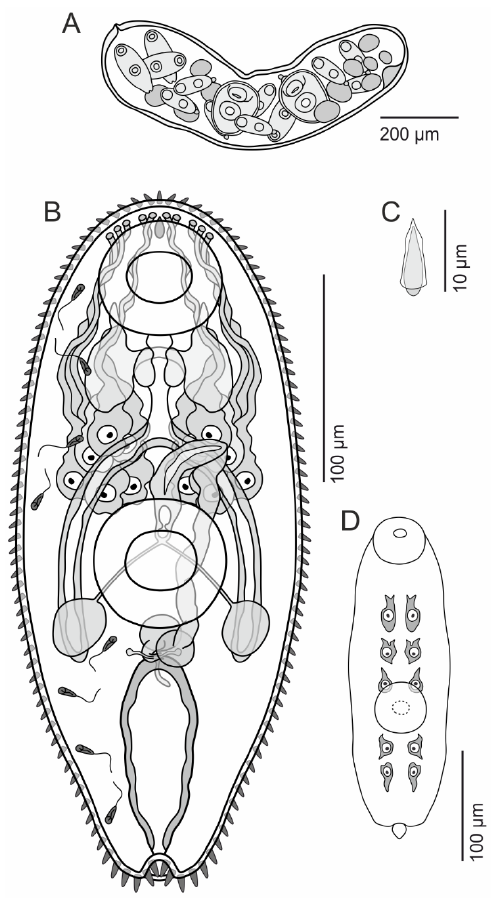
Figure 6. Drawings of life cycle stages of Pseudozoogonoides subaequiporus : sporocyst ( A ), infective cercaria body structure ( B ), stylet, ventral view ( C ), mucoid gland cells and the tail primordium in underdeveloped cercaria ( D ).